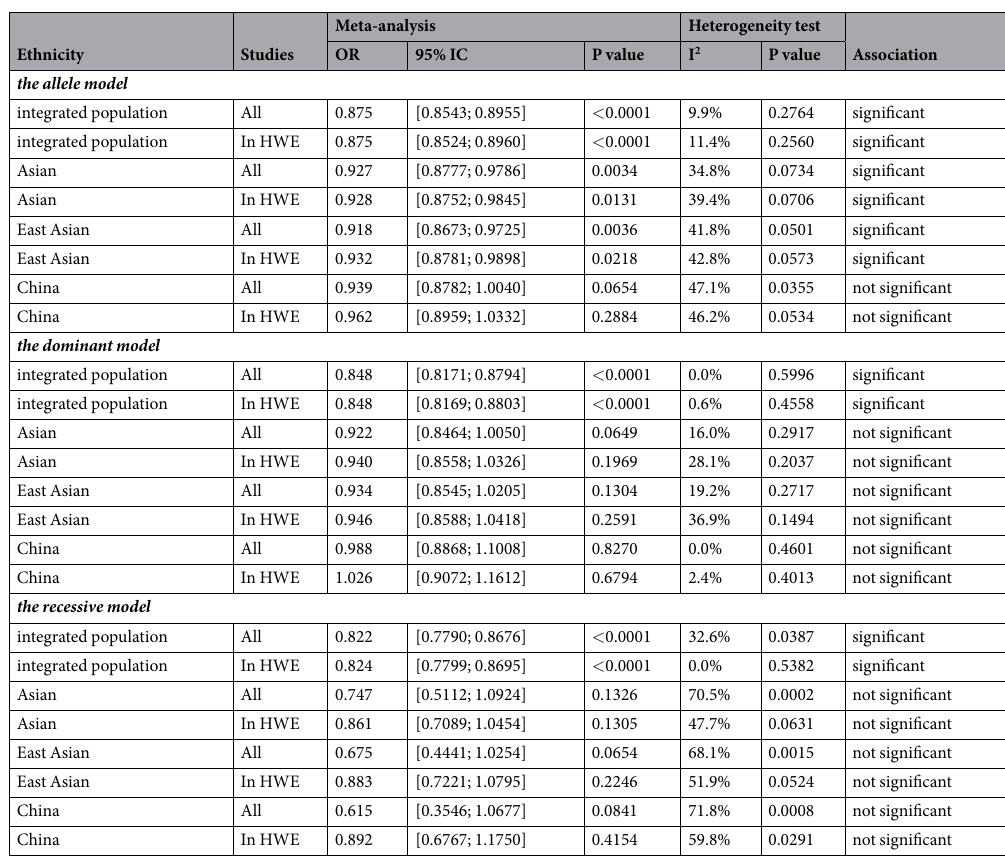
Table 2. The results of meta-analysis after removing the studies deviated from